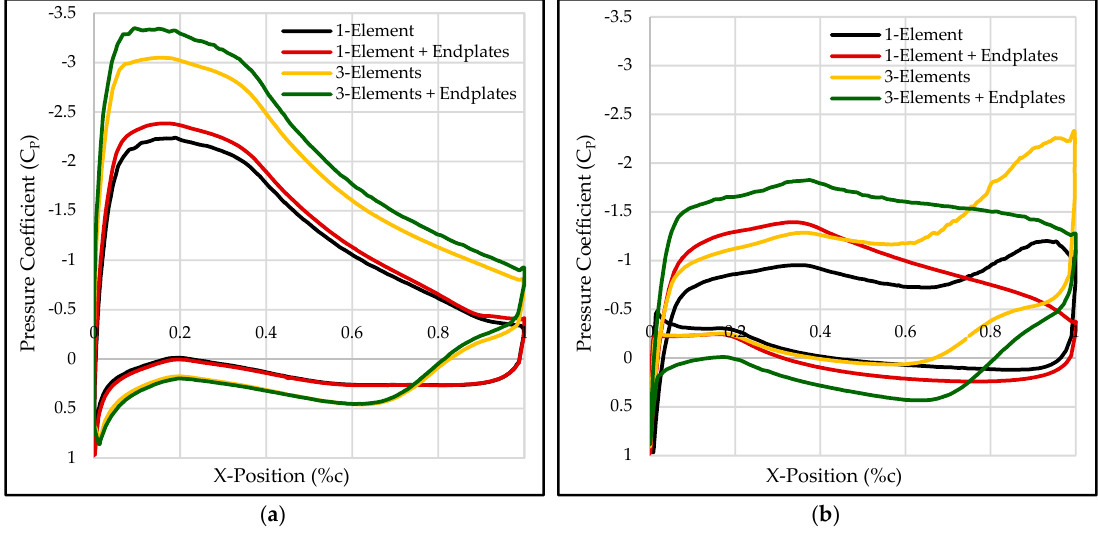
Figure 7. Pressure distribution in baseline configurations at sections: ( a ) 0.05 s; ( b ) 0.95 s.